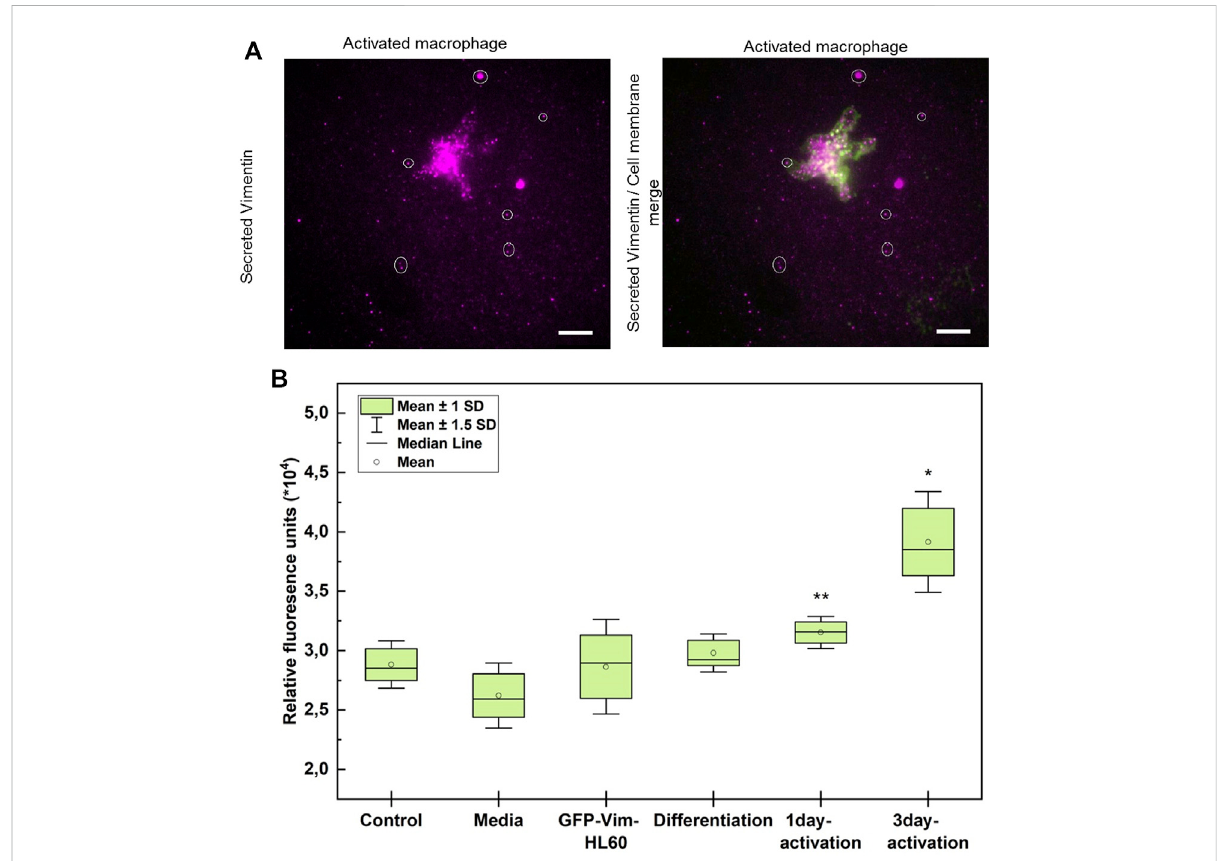
FIGURE 5 TNF- α – activated macrophages secrete vimentin into the extracellular space. (A) Representative total internal re fl ection fl uorescence microscopyofsecretedvimentin(magenta)aroundaTNF- α – activatedmacrophage(green,cellmembrane).Scalebaris10 µm. (B) Quanti fi cationof therelative fl uorescenceofvimentininthemediafromactivatedmacrophagesexpressingGFP-taggedvimentin(repeated2 timeswithsixreplicates of each condition). Conditions: Control, blank; media, RMPI; Differentiation, media from differentiated macrophages; 1 day activation TNF- α ; 3 days activation, media from macrophages activated for 3 days with TNF- α . * p < 0.05; ** p < 0.01 (Student ’ s